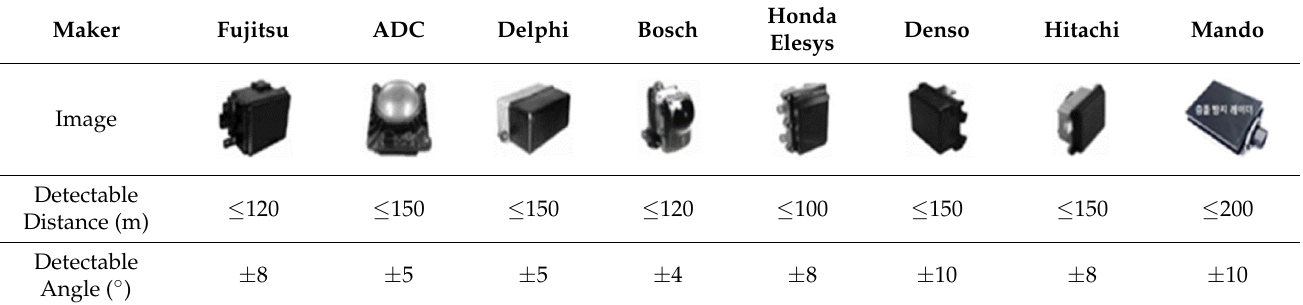
Table 1. Radar sensor of manufacturing companies.